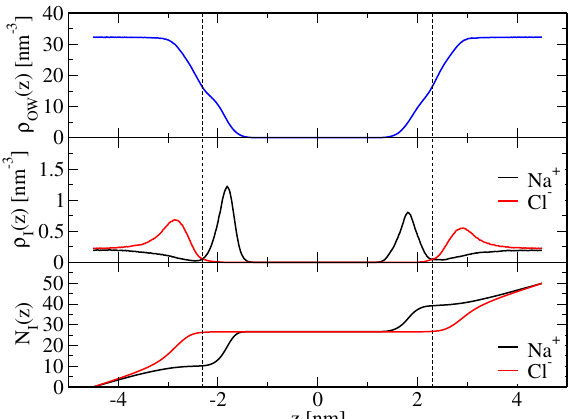
Figure 1. Profiles of water ( ρ OW ( z ) ) and ion ( ρ I ( z ) ; I = Na + or Cl − ) number densities normal to the membrane, along with integrated ion density profiles giving the cumulative number of ions ( N I ( z ) ; I = Na + or Cl − ), for simulation S NaCl (o,wc), i.e., a simulation based on the unmodified force field (Table 7). The dashed vertical lines indicate z -values where the water oxygen number density evaluates to half of its bulk value, i.e., the location of the shear plane z s (Section 4.3.2). The corresponding apparent binding constants are reported in Table 2. Note that in this illustration, the lipid bilayer is